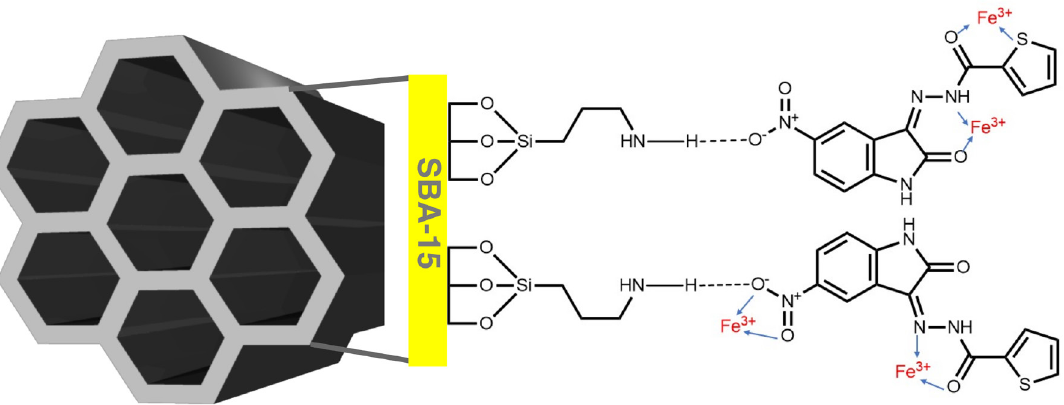
Figure 8: Proposed plausible mechanism for the interaction of ligand NH as the sensing site in the hybrid material SBA-15/APTES-NH for the detection of Fe 3+